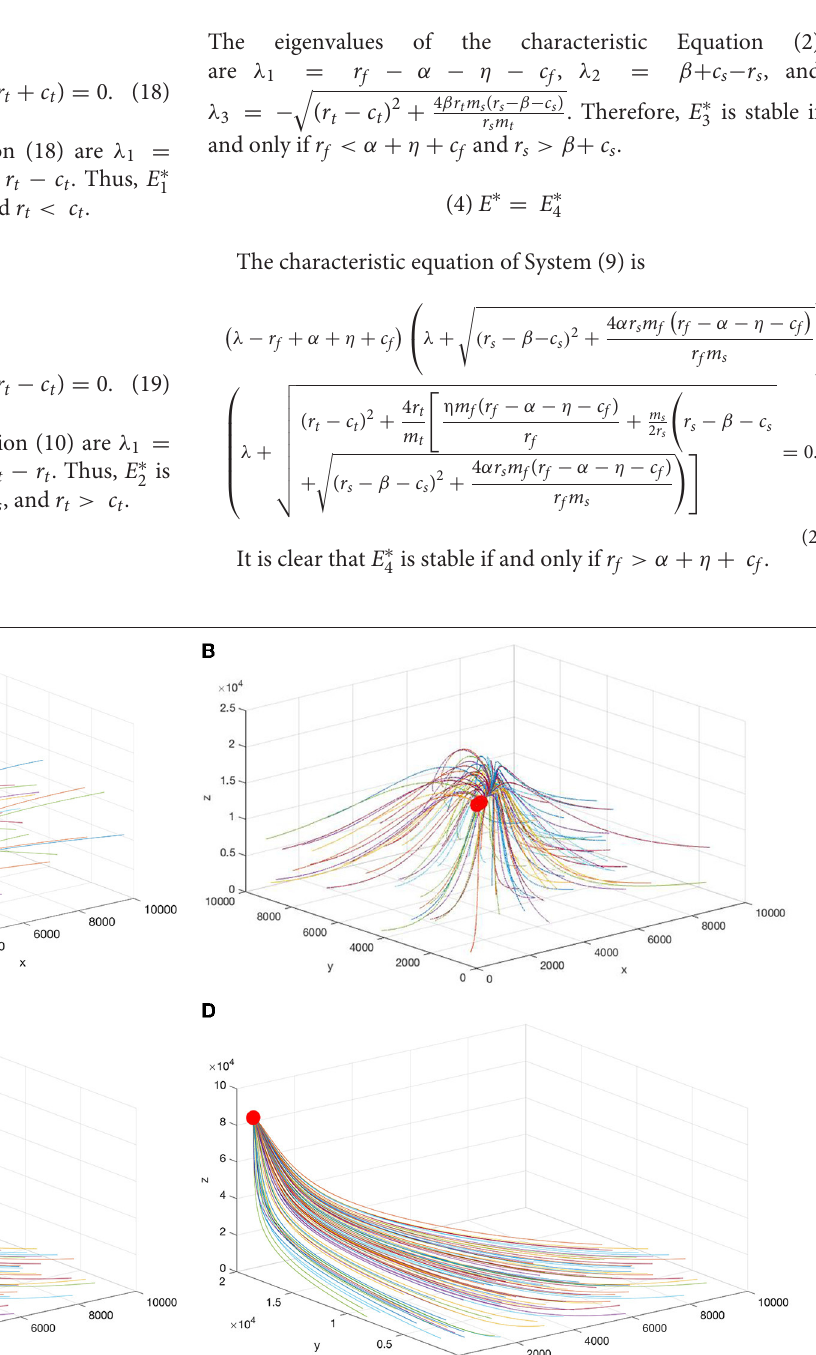
Frontiers in Public Health |